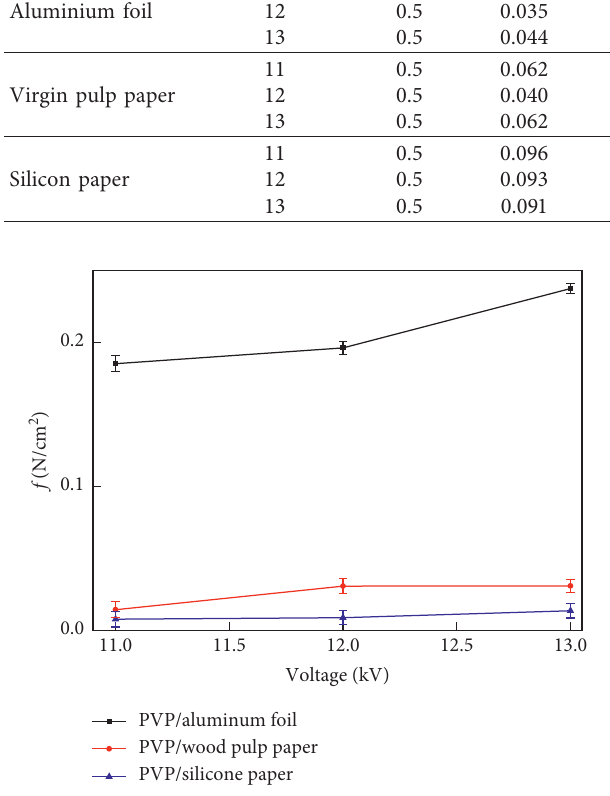
Figure 4: Plots of the adhesion force f varied with increasing spinning